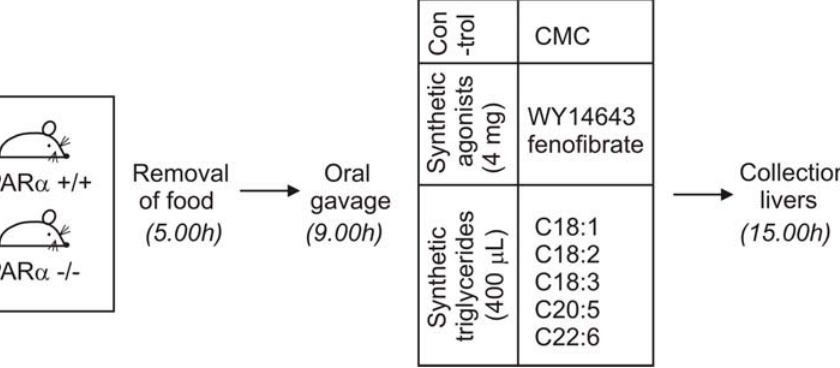
Figure 1. Schematic representation of dietary intervention. Wild-type and PPAR a 2 / 2 mice fasted for 4 hours were given a single oral dose of different synthetic triglycerides composed of one single unsaturated fatty acid (400 m l), or one of the PPAR a agonists WY14643 or fenofibrate (4 mg). After 6h, the livers were used for gene expression profiling using Affymetrix Mouse Genome 430 2.0 Microarrays ( , 45000 probesets) on biological replicates. CMC=carboxymethyl